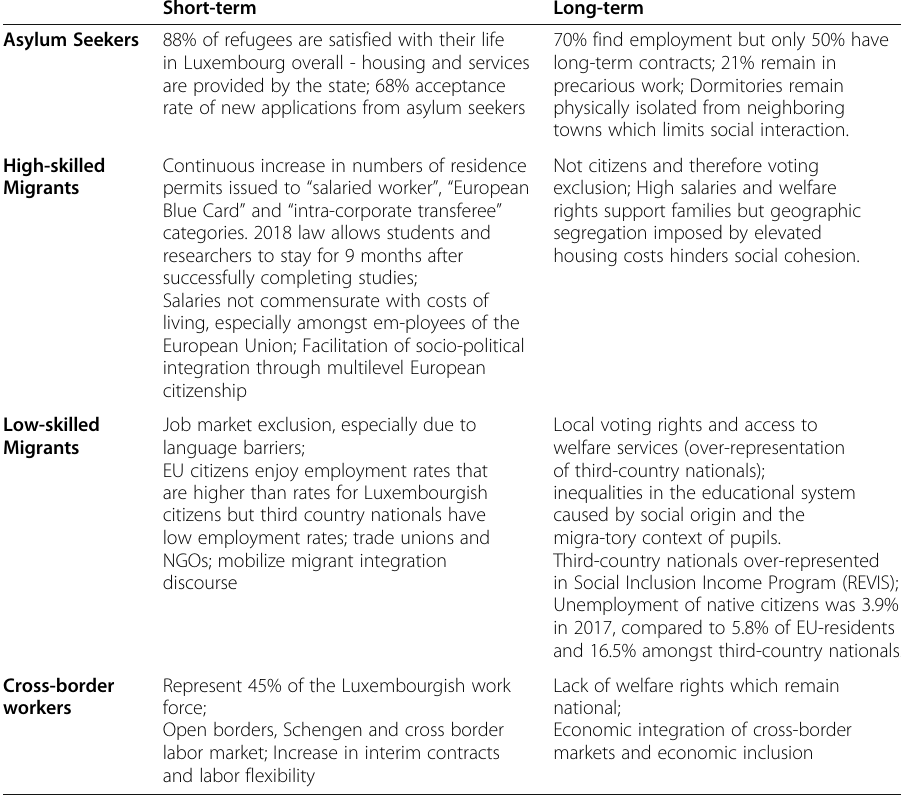
Table 1 Short-term and long-term integration and exclusion of migrant groups in Luxembourg Short-term Long-term Asylum Seekers 88% of refugees are satisfied with their life 70% find employment but only 50% have in Luxembourg overall - housing and services long-term contracts; 21% remain are provided by the state; 68% acceptance rate of new applications from asylum seekers